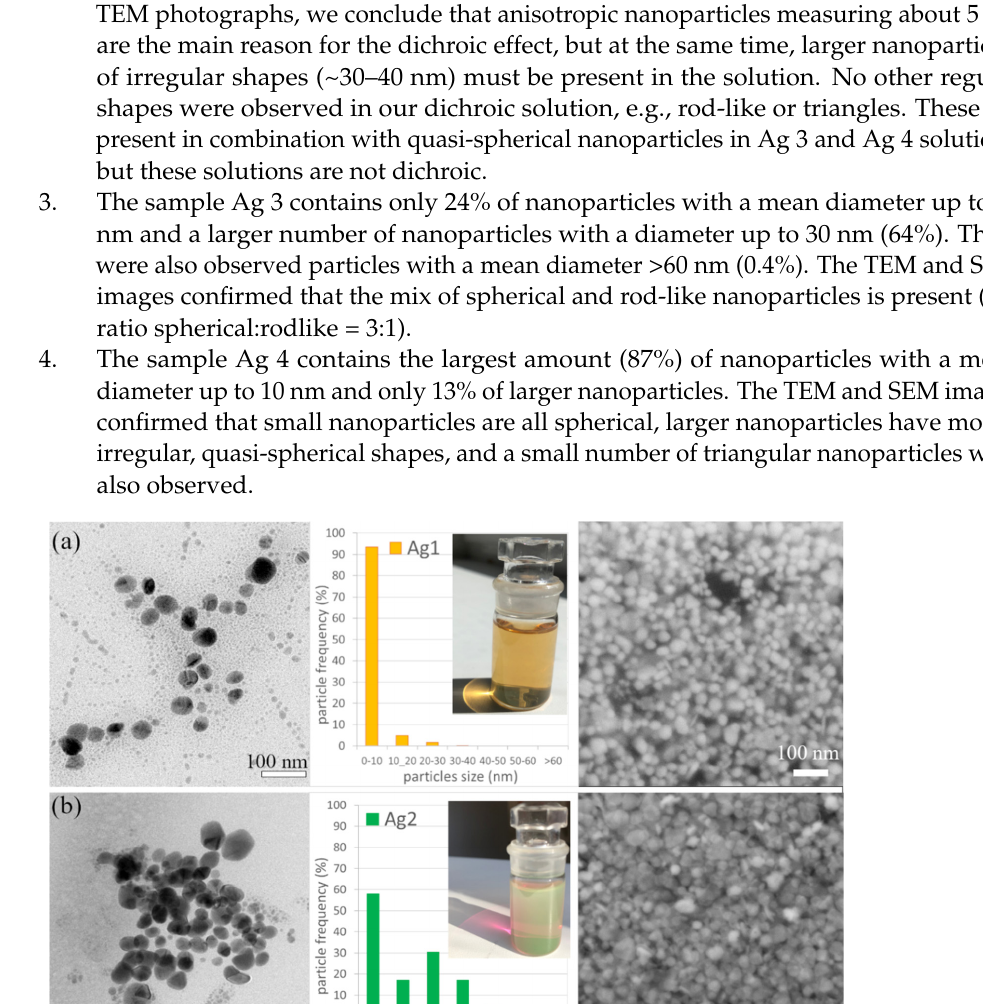
Figure 7. TEM image of small and irregular AgNPs, and AgNPs of quantum dots size ( a ); the thin layer of polymer composite with incorporated dichroic AgNPs (from left to right: reflected and transmitted light) ( b ); and triangular nanoparticles incorporated into PVA matrix ( c ).